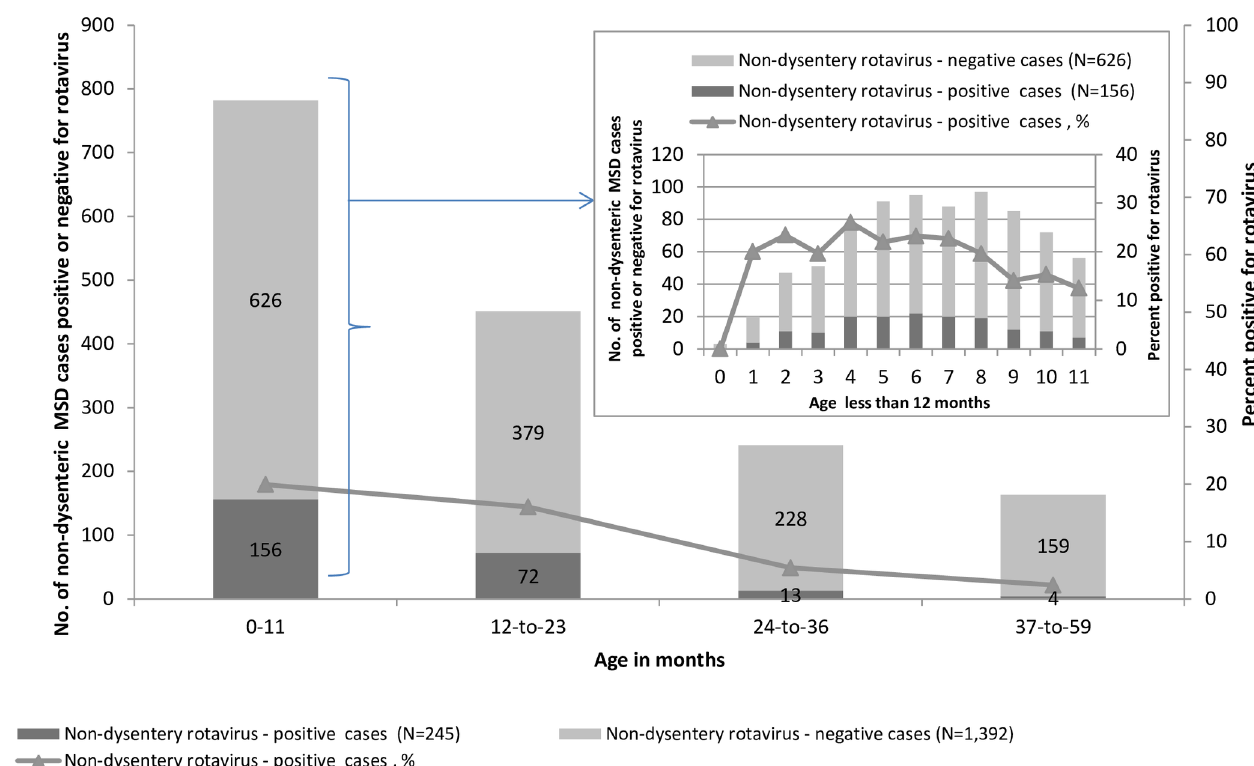
Fig 3. Rotavirus positivity among non-dysenteric MSD cases by age group, western Kenya 2008 – 2012.